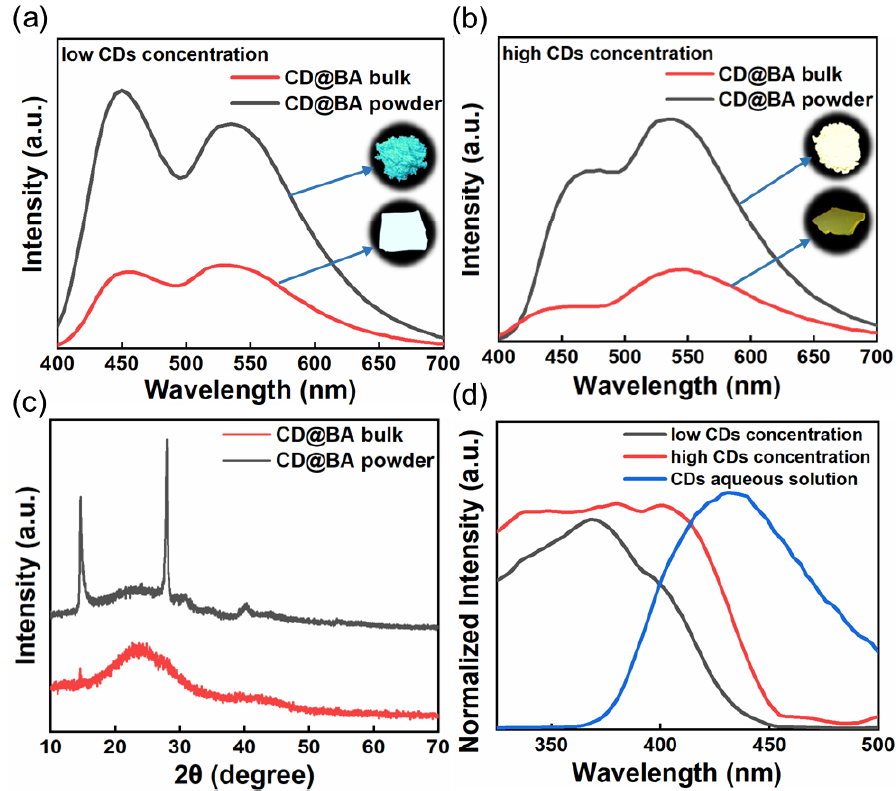
Figure 3. ( a ) PL emission spectra and digital picture of the CD@BA bulk and CD@BA powder at low CDs concentration under 365 nm lamp; ( b ) PL emission spectra and digital picture of the CD@BA bulk and CD@BA powder at high CDs concentration under 365 nm lamp; ( c ) XRD spectra of the CD@BA bulk and CD@BA powder; ( d ) The excitation spectra (λ em = 530 nm) of CD@BA with different CDs concentrations and FL emission spectrum of the CDs aqueous solution (blue line).